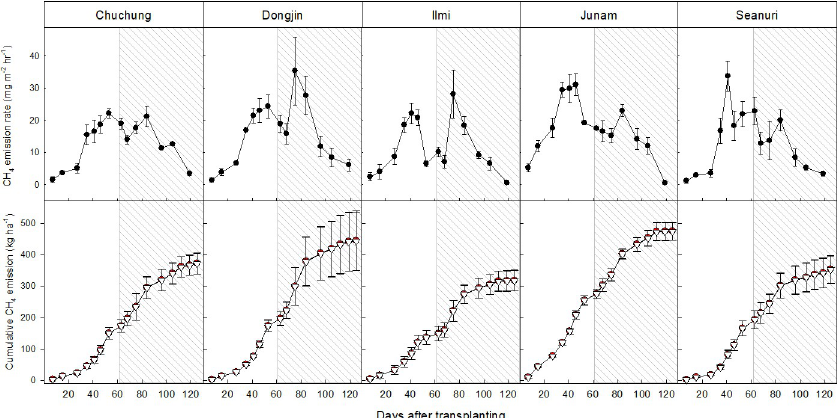
Fig 5. Changes in CH 4 emission rates (above) and cumulative CH 4 emissions (below) which were calculated by with (white triangle) and without (red circle) biomass volume consideration during rice cropping season. White and shaded areas indicate the vegetative and reproductive stage of rice plant,